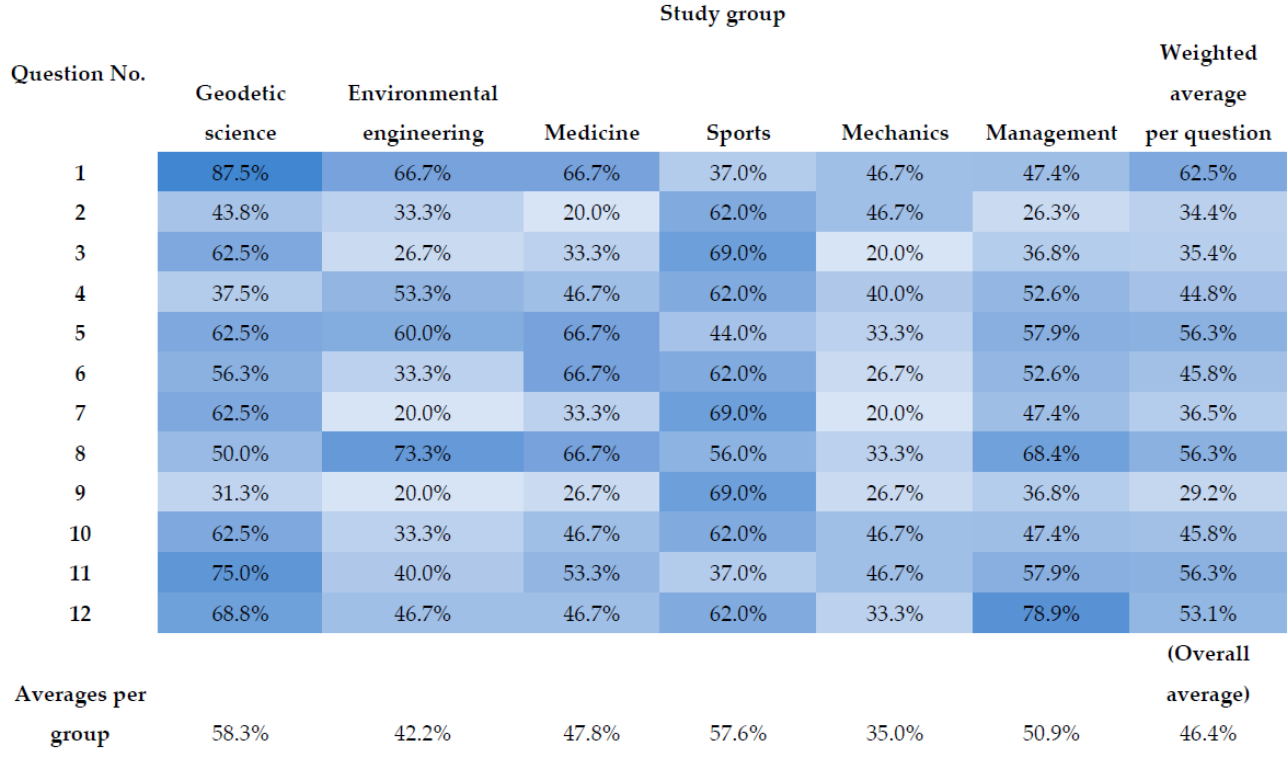
ISPRS Int. J. Geo-Inf. 2023 , 12 , x FOR PEER REVIEW Figure 5. Percentage of correct answers given by men to questions 1 – 12 overall and in the study Figure 5. Percentage of correct answers given by men to questions 1–12 overall and in the study groups. groups.